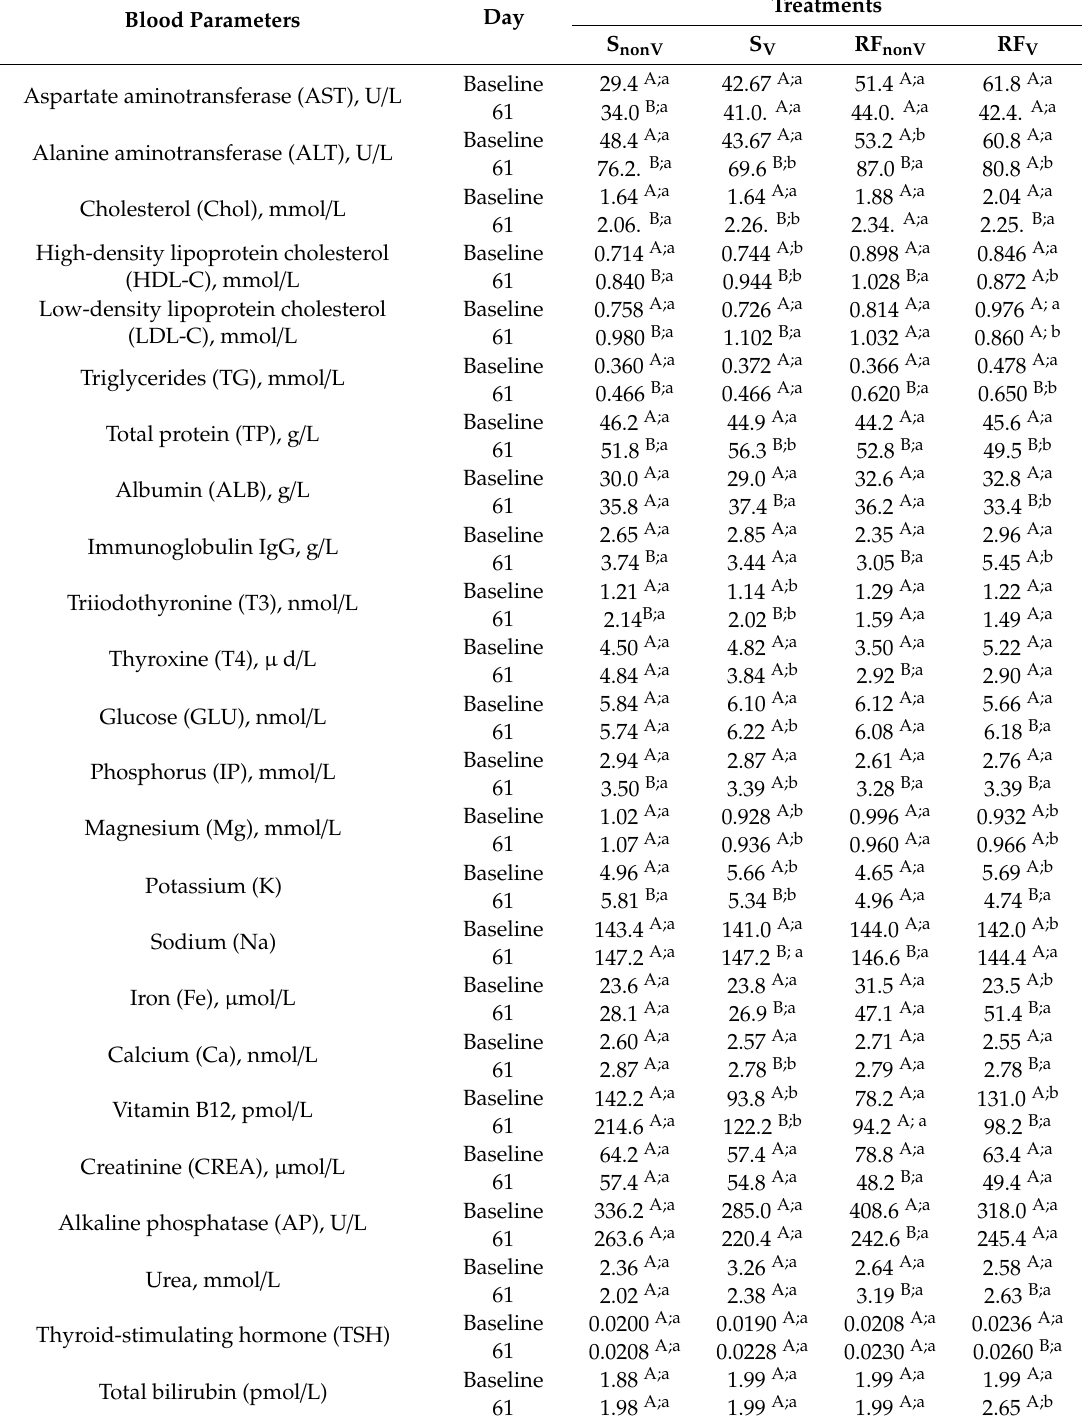
Table 3. Piglets’ blood